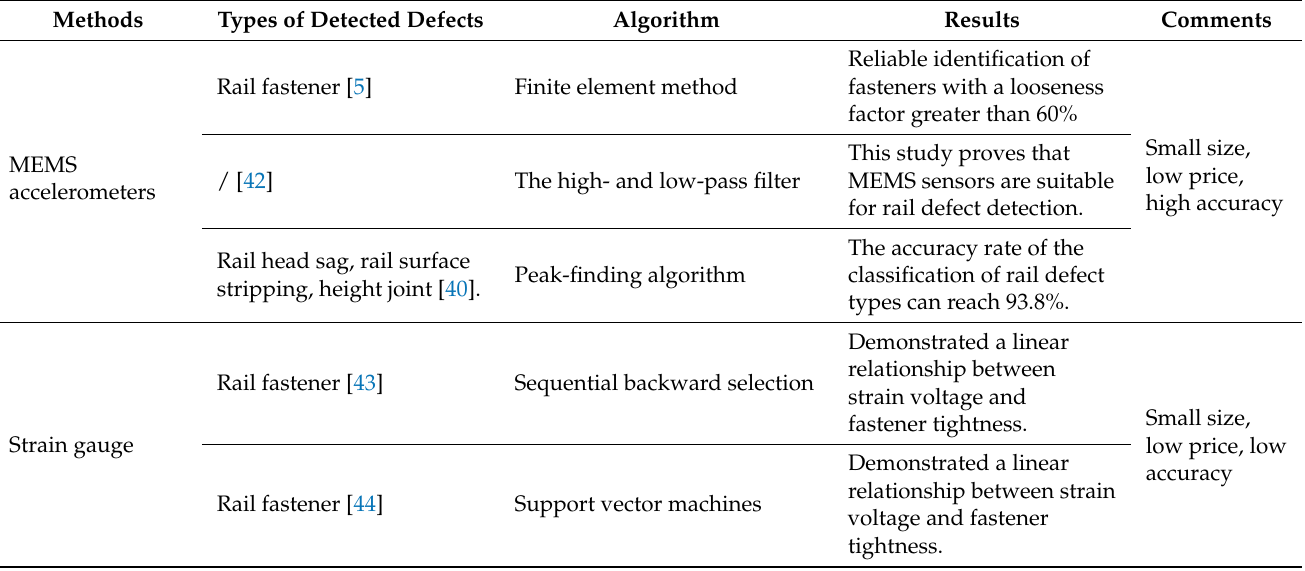
Table 1. Comparison of vibration testing methods.